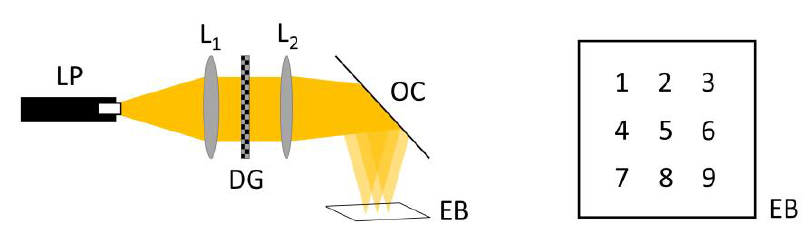
Figure 6. Schematic plot of the established Maxwellian view display with an enlarged eyebox. The eyebox is enlarged in 2D space, and the different viewpoints are numbered with the central view (0th diffraction order) numbered as #5. LP: laser projector; L 1 : collimation lens; DG: Dammann grating; L 2 : eyepiece; OC: optical combiner; EB: eyebox.